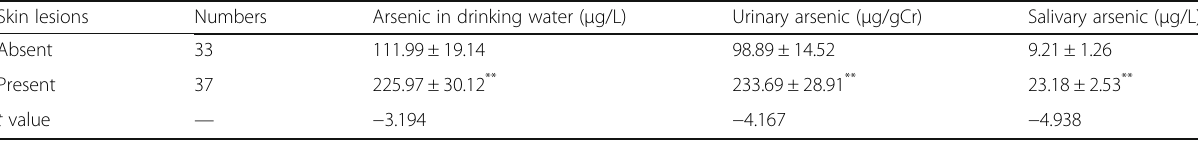
Table 2 Relationship between skin lesions and total arsenic (TAs) concentrations in drinking water, urine and saliva